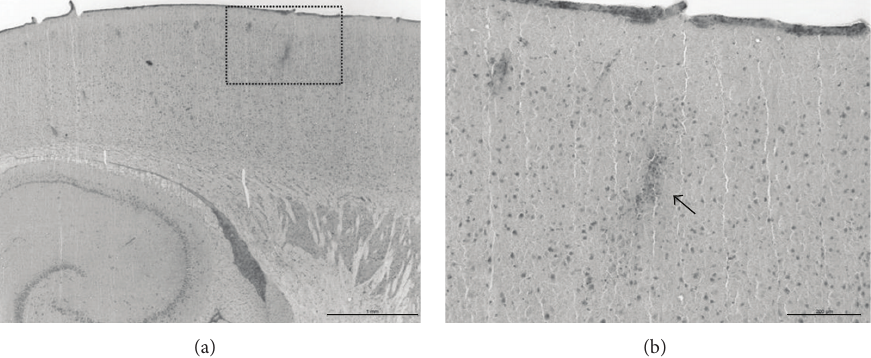
Figure 4: H&E stained section with cortical microinfarct in the cortical layers in a nontreated animal (a). At higher magnification mononuclear infiltration can be distinguished (b, arrow). Scale bar corresponds to 1000 𝜇 m (a) and 200 𝜇 m (b),